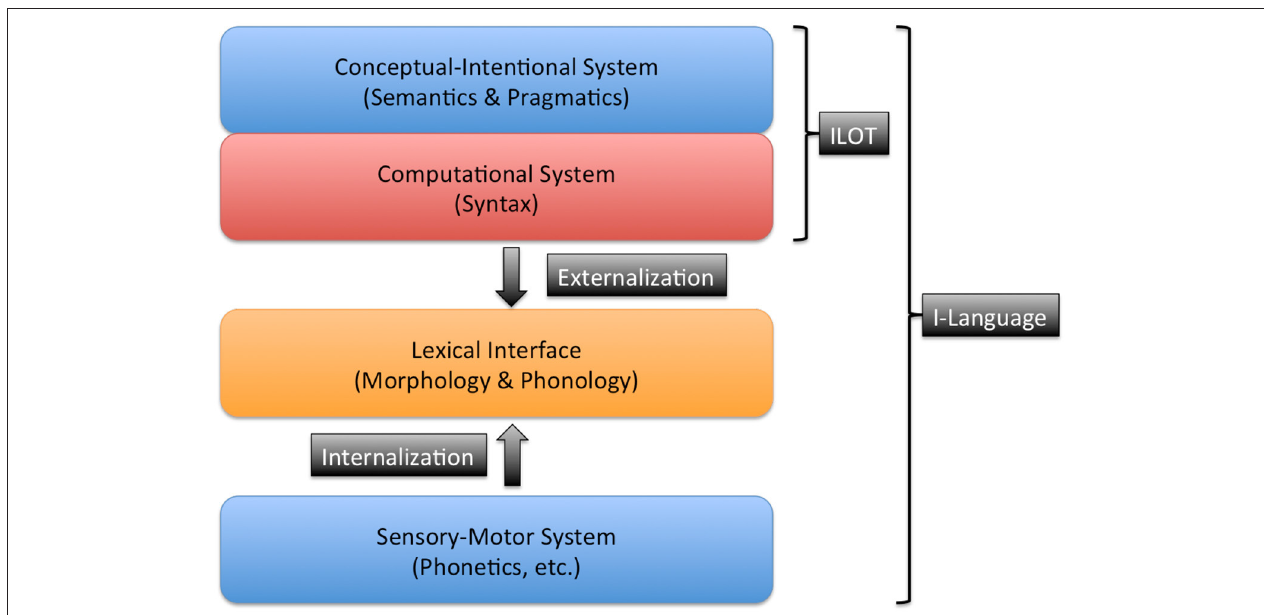
FIGURE 1 | The structure of an I-language. For each component the traditional area of research is indicated. The main components of language are asymmetrically related. The conceptual-intentional (CI) system has a direct connection with the computational system and they form an internal language of thought (ILOT). This ILOT is connected with the sensory-motor (SM) system for language externalization. This connection is established through a lexical interface. The lexical interface changes historically during the process of transmission from generation to